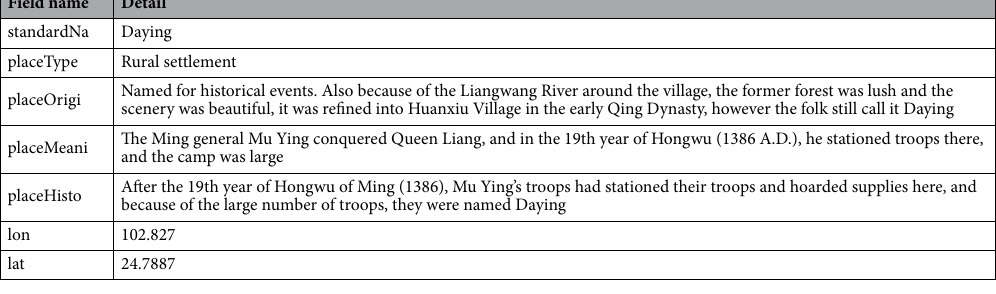
Table 1. Toponym information of second national toponymic census in